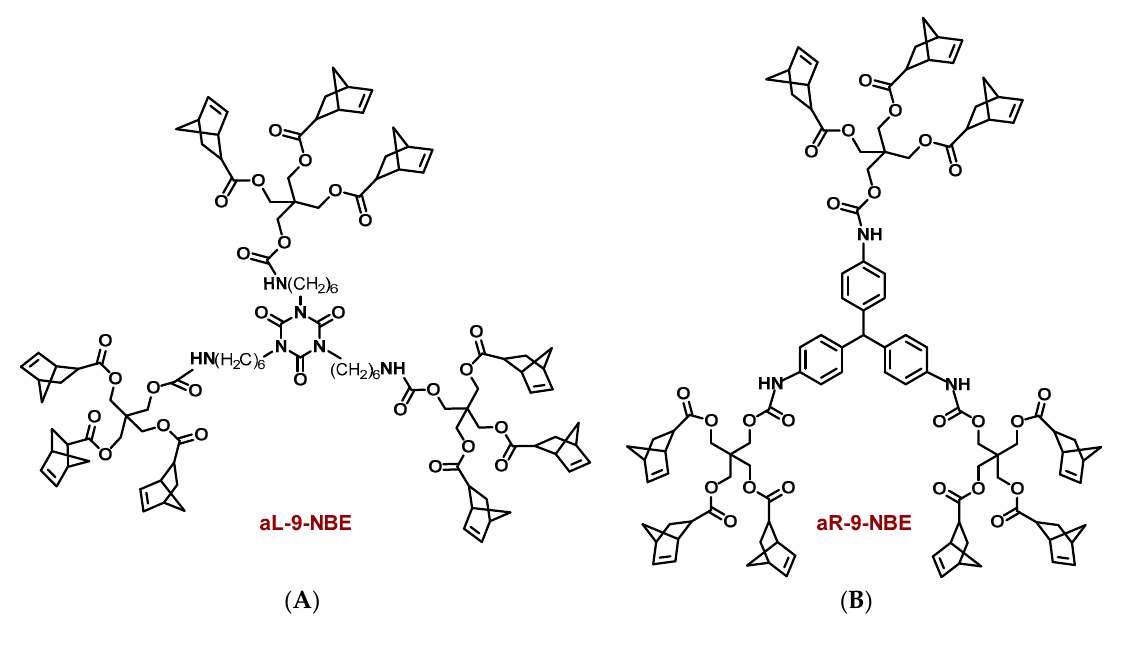
Figure 2. Structures of aL-9-NBE ( A ) and aR-9-NBE ( B ).